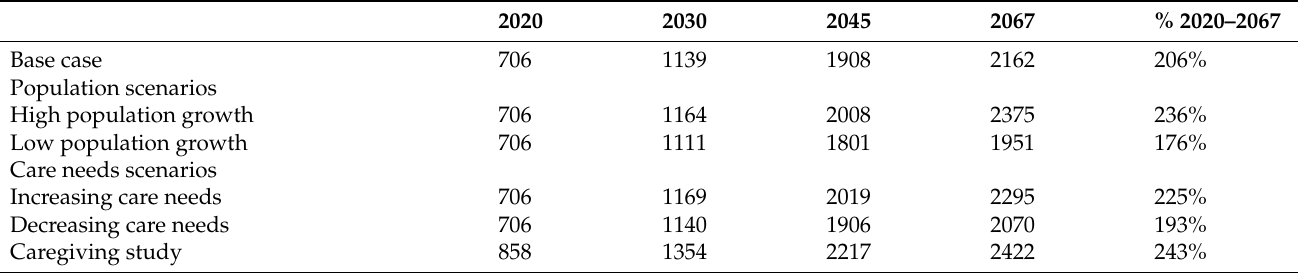
Table 5. Sensitivity analysis of projected demand for informal care (unit: thousand